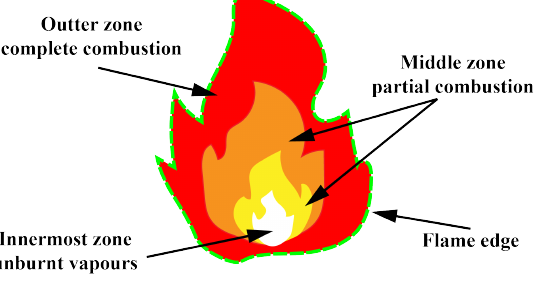
Figure 5. Structure of flame.